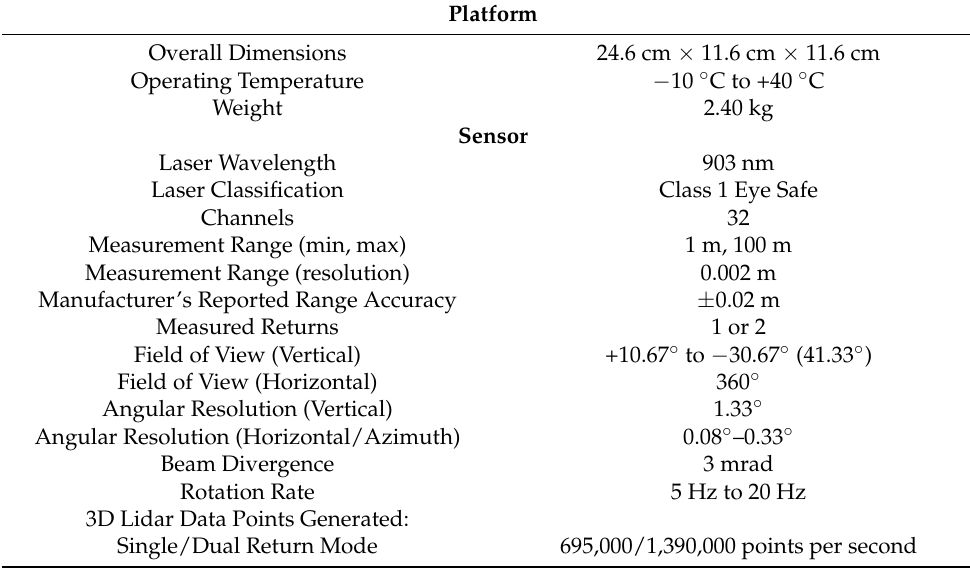
Table 1. Velodyne ® HDL–32E Select Specifications [13].